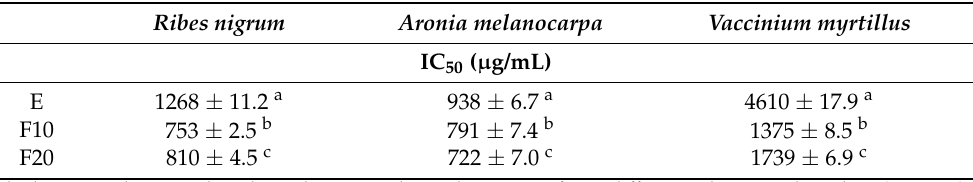
Table 4. Values of IC50 of DPPH radical scavenging for R. nigrum , A. melanocarpa , and V. myrtillus extract and kombucha ferments after 20 min of exposure. Values are means ± standard deviation (SD) of triplicate.